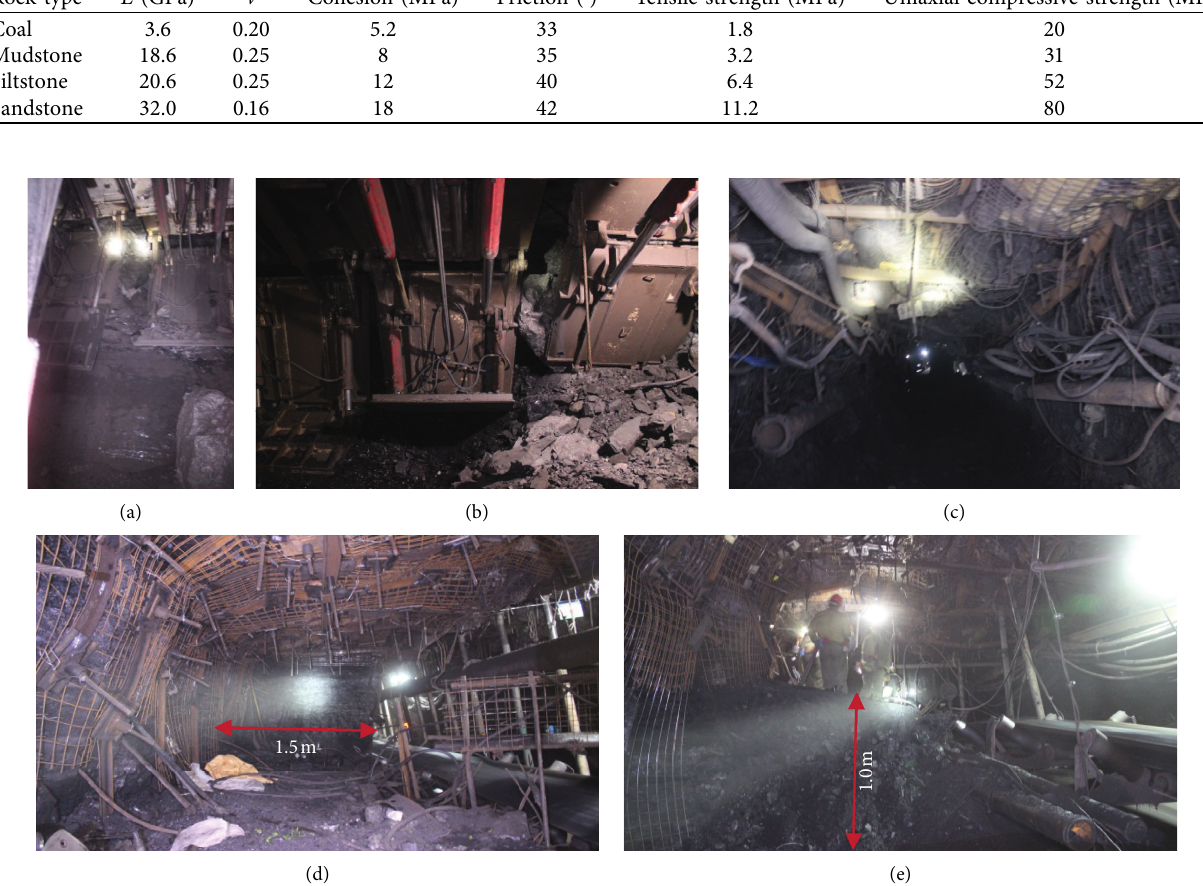
Figure 2: Surrounding rock instabilities. (a) Face fall. (b) Roof fall. (c) Large deformation of the gate. (d) Rib expanding. (e) Floor